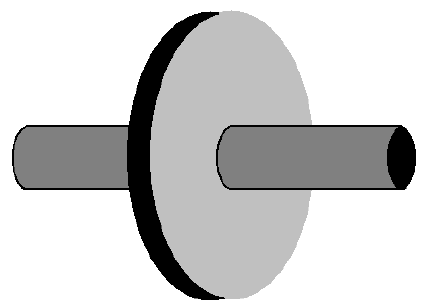
Figure 2. A radial fin with constant thickness δ , installed in a tube with radius r = x 0